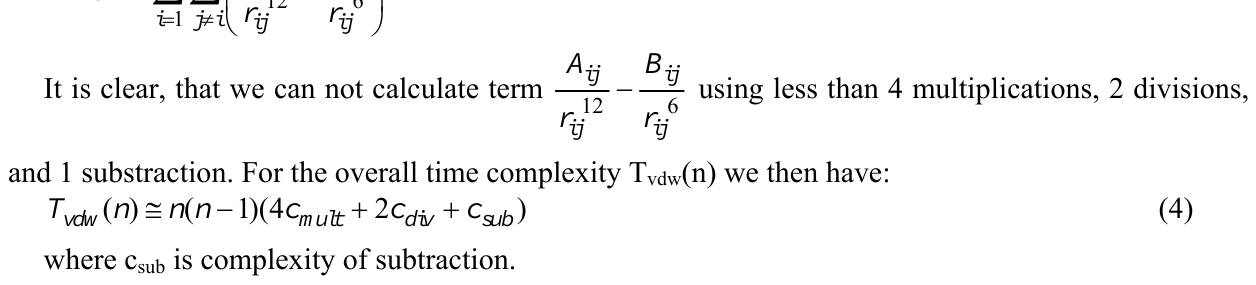
Table 2. Ratio of computational complexities of van der Waals (T